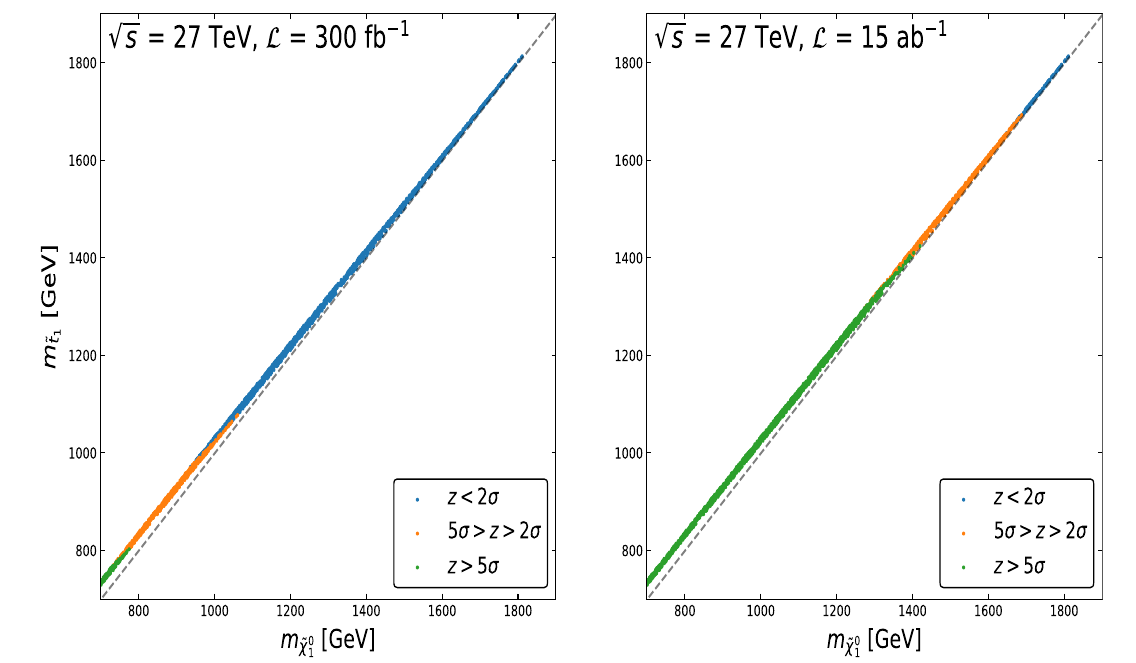
Fig. 9 Same as Fig. 5, but for the monojet events from the process pp → ˜ t 1 ˜ t ∗